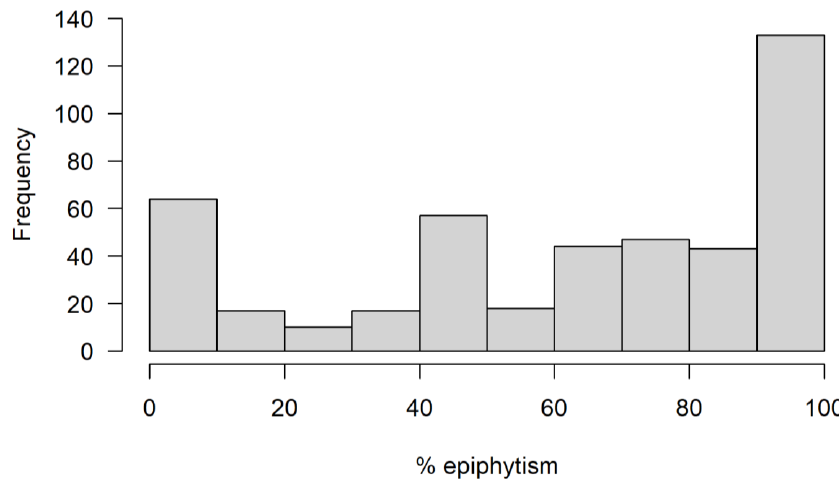
Figure 1. Histogram showing the tendency of 450 species of Hymenophyllaceae to occur epiphytically. In a second analysis, we used a triangular ordination to include preferences for epi- phytic, lithophytic and terrestrial growth in a single analysis (Figure 2). While obligate epiphytes (EV > 0.9) make up just about 30% of all species of filmy ferns, there is clearly a preference for epiphytic growth in Hymenophyllaceae. About 68% of all taxa grow primar- ily as epiphytes, i.e., can be found in the lower left triangle of the epiphyte-lithophyte- terrestrial space, i.e., EV ≥ 0.5, whereas species with LV and TV ≥ 0.5 made up about 11% and 16%, respectively (note that in these calculations we assigned half of the species at the border, e.g., EV = LV = 50% to either E or L). Obligate lithophytes (LV > 0.9) and obligate terrestrial taxa (TV > 0.9) make up less than, respectively, 4% and 6% of all species. A similarly small number of species could be called “generalists” with <50% preference for any of the three growing sites (6%).